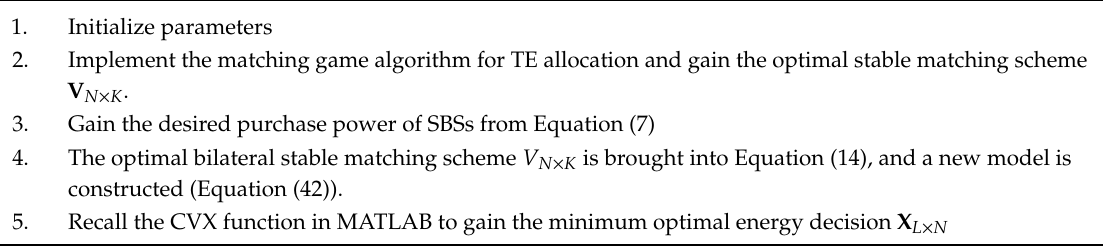
Algorithm 2: Algorithm for Minimum Cost of Energy